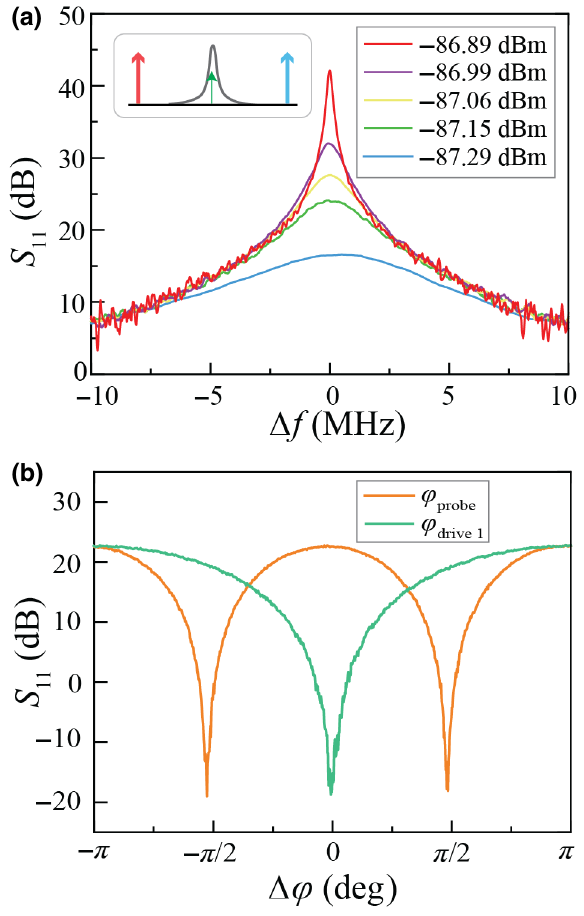
FIG. 2. (a) Phase-preserving amplification characterized by a reflective vector network analyzer measurement. To enable gain, we apply a two-tone drive with two frequencies each detuned from the resonant frequency by over two linewidths. (b) Phase- sensitive amplification and deamplification. In this measurement, we send a probe signal at the frequency of f s = ( f p 1 + f p 2 )/ 2. By varying the phase of signal tone and one of the drive tones (data shown for f p 1 ), we observe an oscillation between amplification and deamplification with a period of 2 π for φ s − (φ p 1 + φ p 2 )/